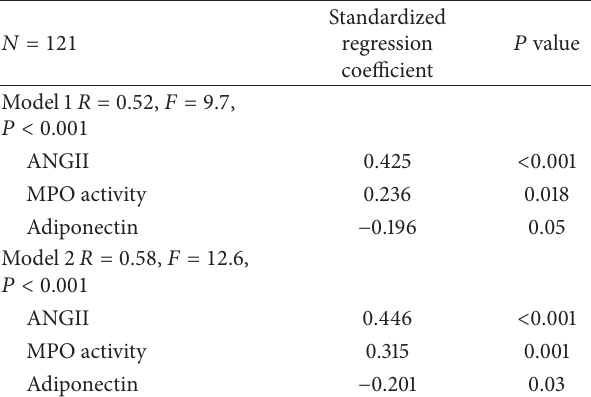
Table 2: Multivariate analysis of backward regressions in the total